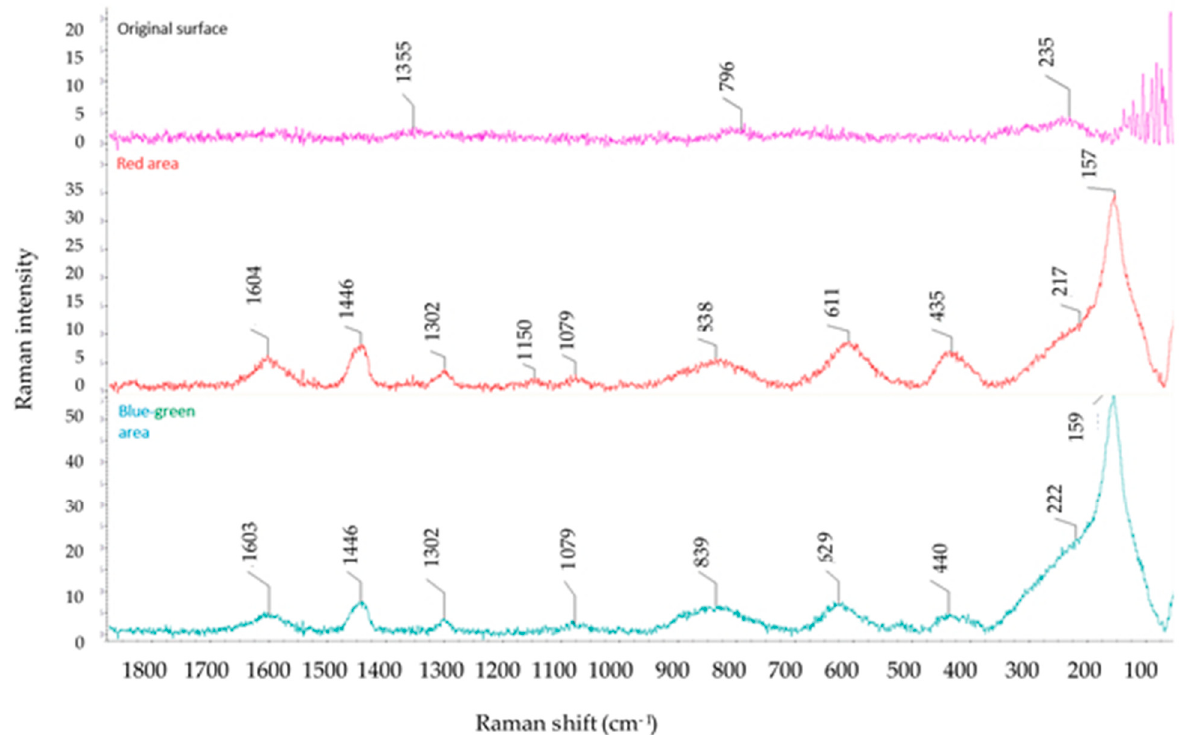
Figure 13. Raman intensity spectra for the original surface, red area and blue-green area.